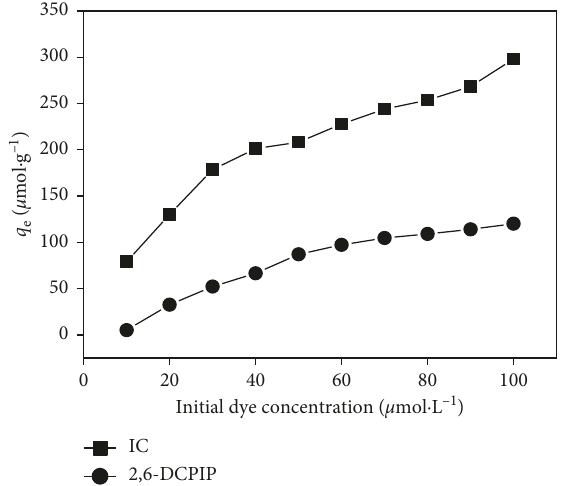
Figure 9: Effect of initial concentration on the IC and 2,6-DCPIP adsorption. Experimental conditions: m � 0.133g · L − 1 ; G � 0–100 μ m; t � 40min and pH � 6.2 for IC; t � 30min and pH � 6.7 for 2,6- DCPIP; v � 150rpm; V � 30mL; at room temperature.